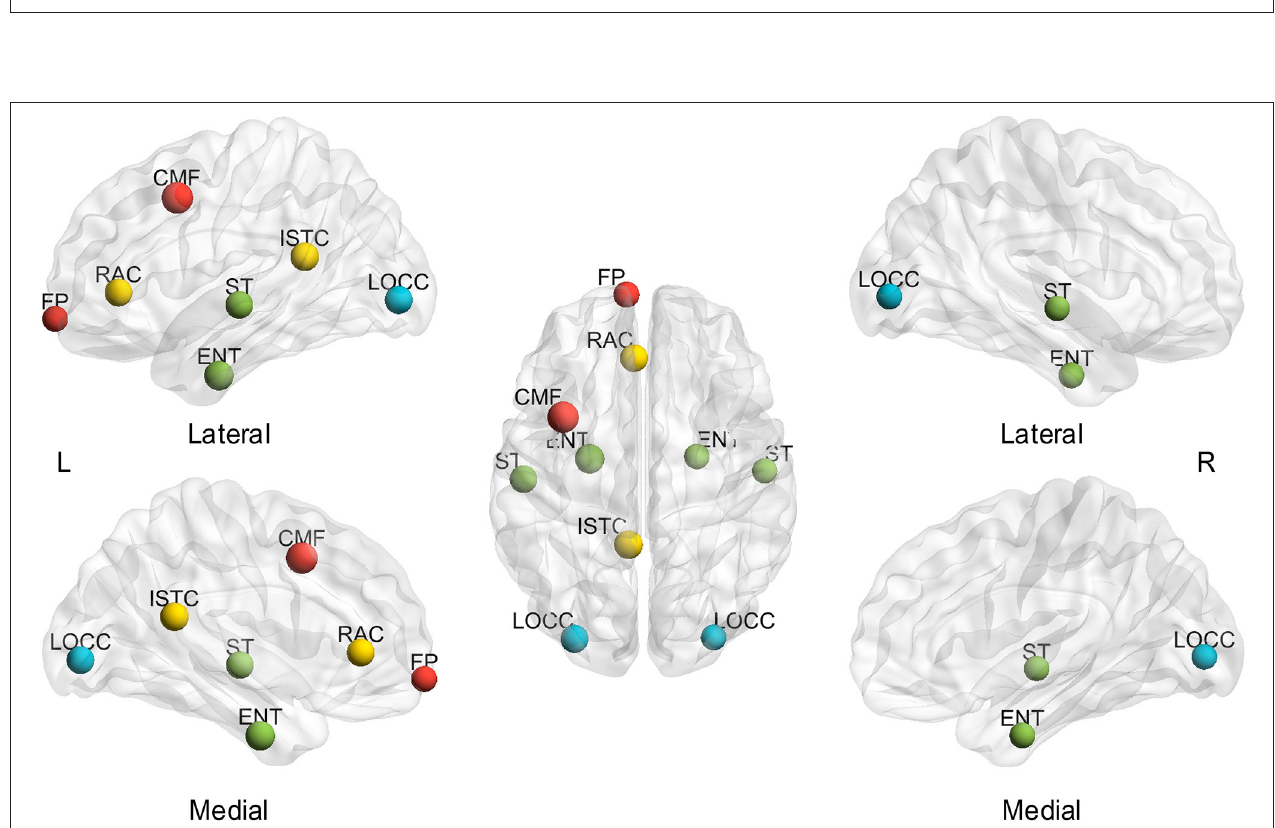
FIGURE 6 | Spatial distribution of hubs identified based on the average of sparsities and subjects. L, left; R, right; A, anterior; P, posterior; CMF, caudal middle frontal gyrus; ENT, entorhinal cortex; FP, frontal pole; ISTC, isthmus cingulate; LOCC, lateral occipital gyrus; RAC, rostral anterior cingulate; ST, superior temporal gyrus. The size of the node represents the value of BC; the largest node denotes 107.22 of BC. The different color of nodes denotes the different lobes: red-frontal lobe; green-temporal lobe; blue-occipital lobe; yellow-cingulate.